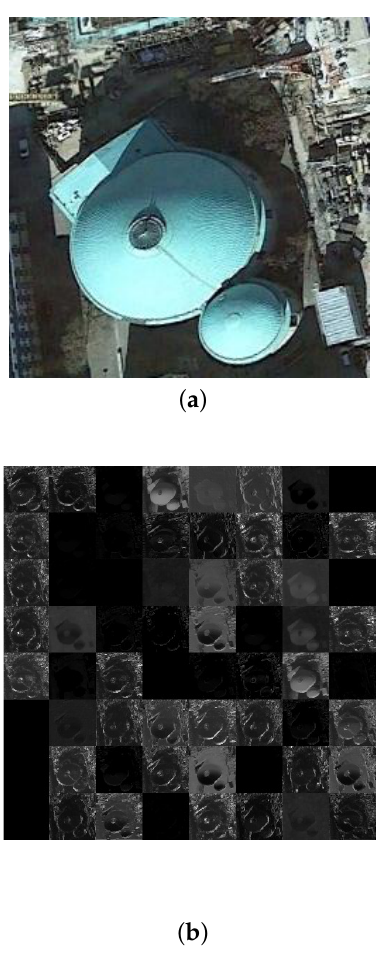
Figure 3. Visualization of shallow features in a remote sensing image. ( a ) Original. ( b ) Visualization of shallow